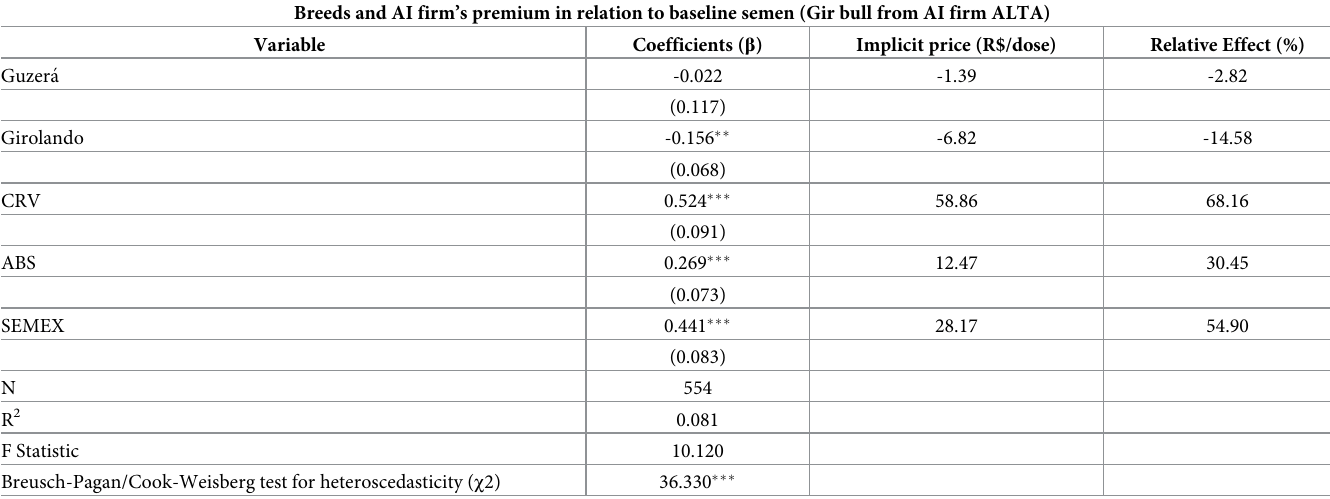
Table 4. Estimated parameters and implicit attribute prices for semen of dairy bulls. Breeds and AI firm’s premium in relation to baseline semen (Gir bull from AI firm